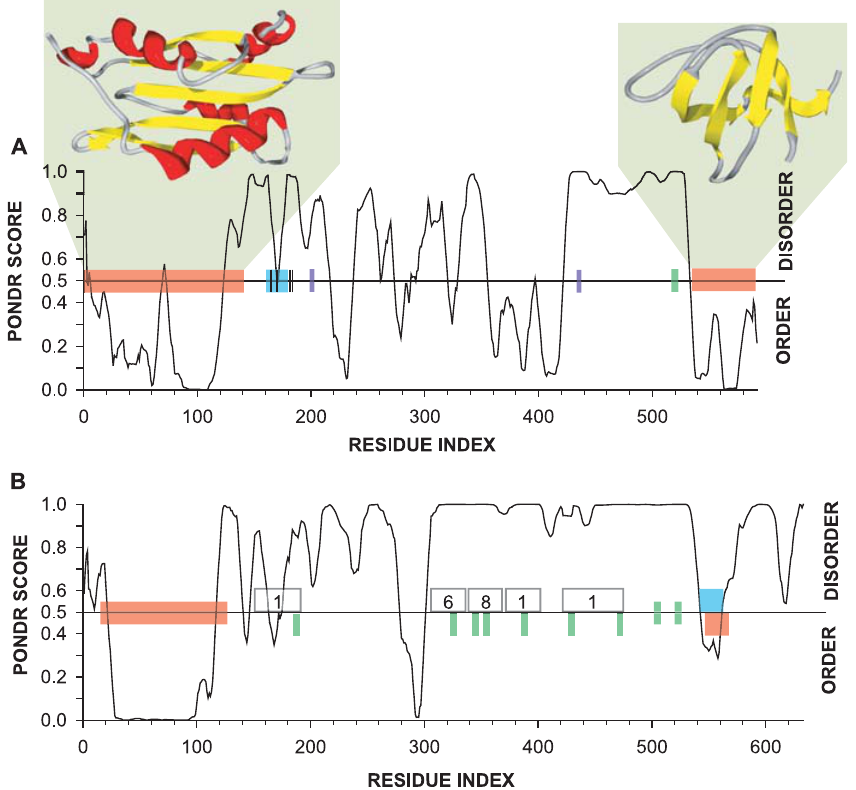
Figure 5. PONDRing Abp1p and Las17p (A) The PONDR VL-XT prediction for Abp1p is plotted along with bars representing the positions of the ADF domain (N-terminal orange bar, structure 1HQZ), the SH3 domain (C-terminal orange bar, structure 1JO8), a poly-proline region (green bar), a predicted a -MoRF (blue bar), known phosphorylation sites (black hash marks), and regions critical for Arp2/3 activation (purple bars). (B) The PONDR VL-XT prediction for Las17p is plotted along with bars representing the positions of the WASP homology domain 1 (N-terminal orange bar), WASP homology domain 2 (C-terminal orange bar), poly-proline regions (green bars), and a predicted a -MoRF (blue bar). The number of interaction partners associated with a given region [39] is indicated in the numbered boxes. DOI: